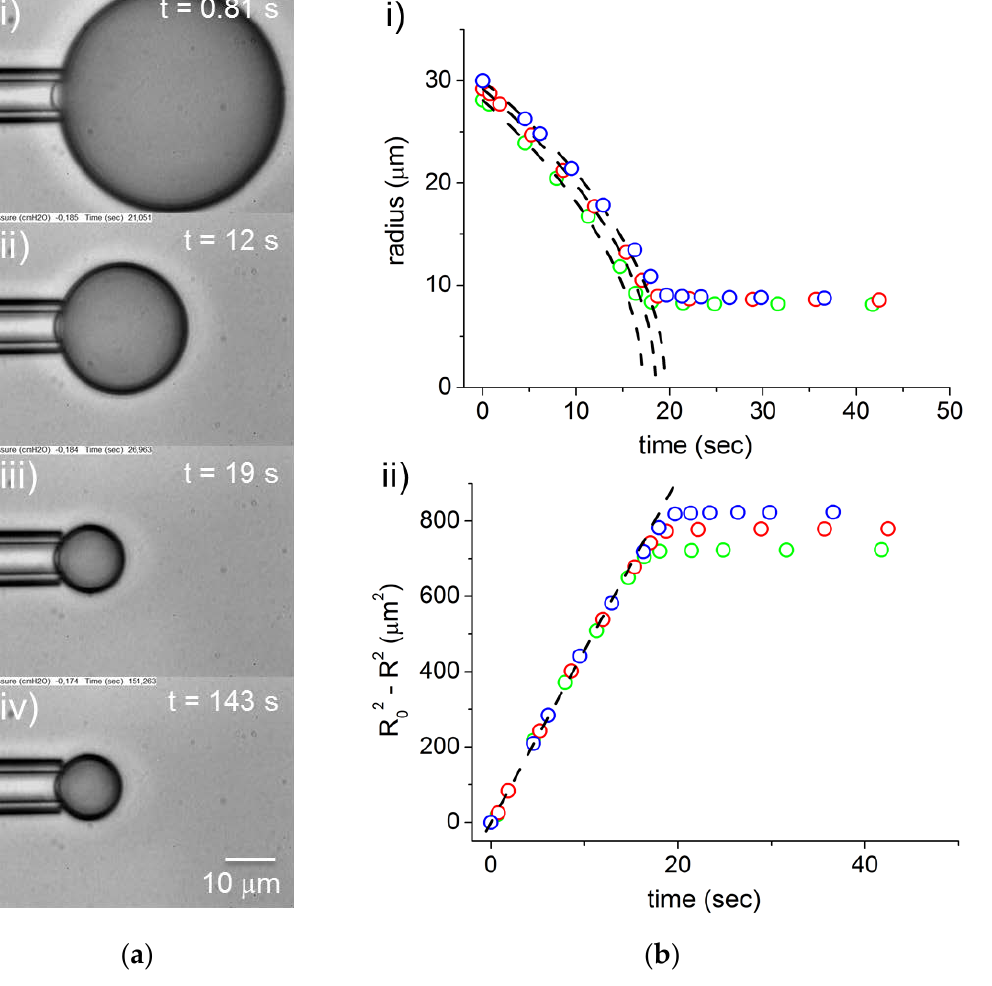
Figure 7. Poly(lactic-co-glycolic acid) (PLGA) microsphere formation by solvent dissolution in 5 mM PBS (pH 7.4) at room temperature. ( a ) Dissolution of DCM from a solution droplet of DCM/PLGA at the tip of the micropipette (PLGA concentration = 25 mg/mL); ( b ) Graphs representing microdroplet dissolution: (i) Droplet radius vs. time for three separate DCM/PLGA microdroplets of dissolving in 5 mM PBS. Extrapolation of the data (green open circles) for the droplet shown in video micrographs (i)–(iv) to radius = 10 µ m, shows that this microdroplet lost almost all of its DCM, in ~19 s and concentrated to a final density of C PLGA = 1,012 ± 20 mg/mL. In this case, the measured loss of DCM − R 2 vs. time plot that gave a DCM diffusion coefficient D = 1.77 ± 0.01 × 10 − 5 cm − 2 /s); (ii) R 2 0 collapsed the data onto a single line up until the PLGA solidified out of the